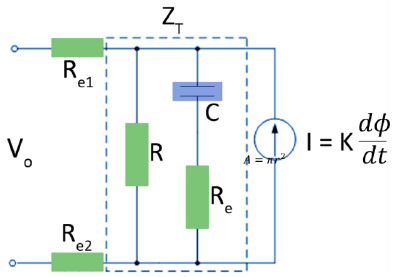
Figure 2. Circuit model of the IPMC material.